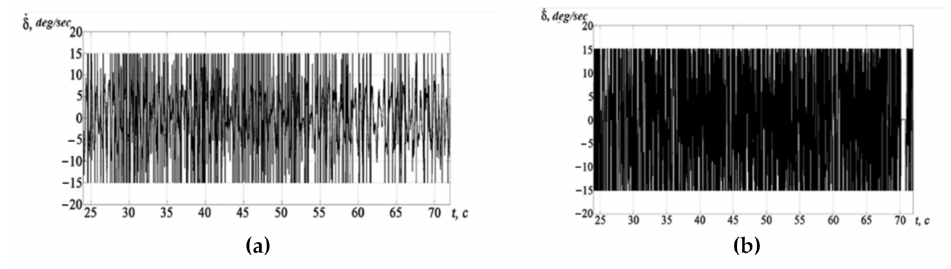
. δ ( t ) of the control signal. ( a ) DSC, ( b ) FSC. Figure 17. Rate